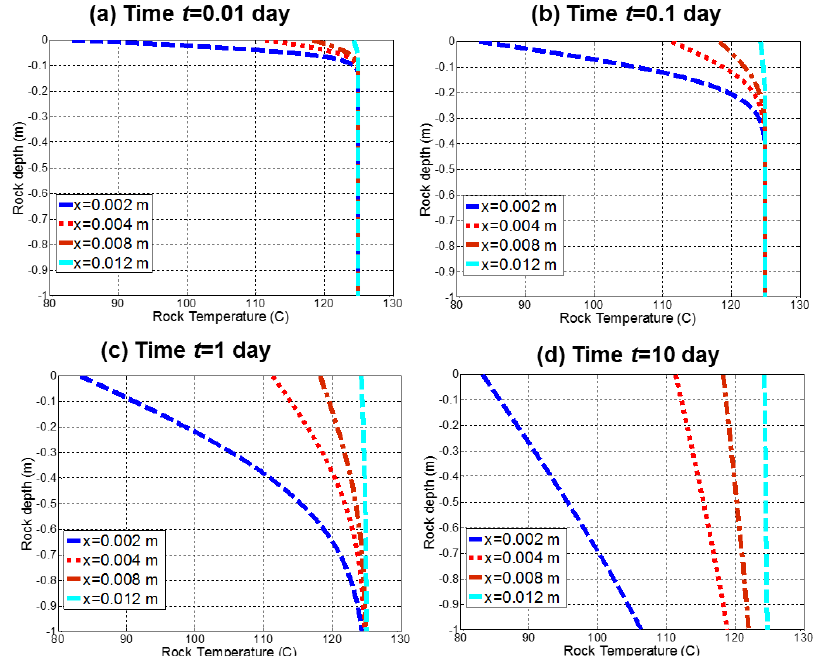
Figure 8. Cooling profile of the host rock at four locations ( x = [0.002, 0.004, 0.008, 0.012] (m)) for different times. ( a ) t = 0.01 day; ( b ) t = 0.1 day; ( c ) t = 1 day; ( d ) t = 10 days. Initial rock temperature is 125 °C. Fracture aperture is 0.005 m. Brine velocity is 0.0001 m/s. The initial fracture wall temperature for time 0 is defined when first fresh injected fluid batch passes by. For example, for x = 0.002 m, the reference time is 0.002/0.0001 = 20 s.